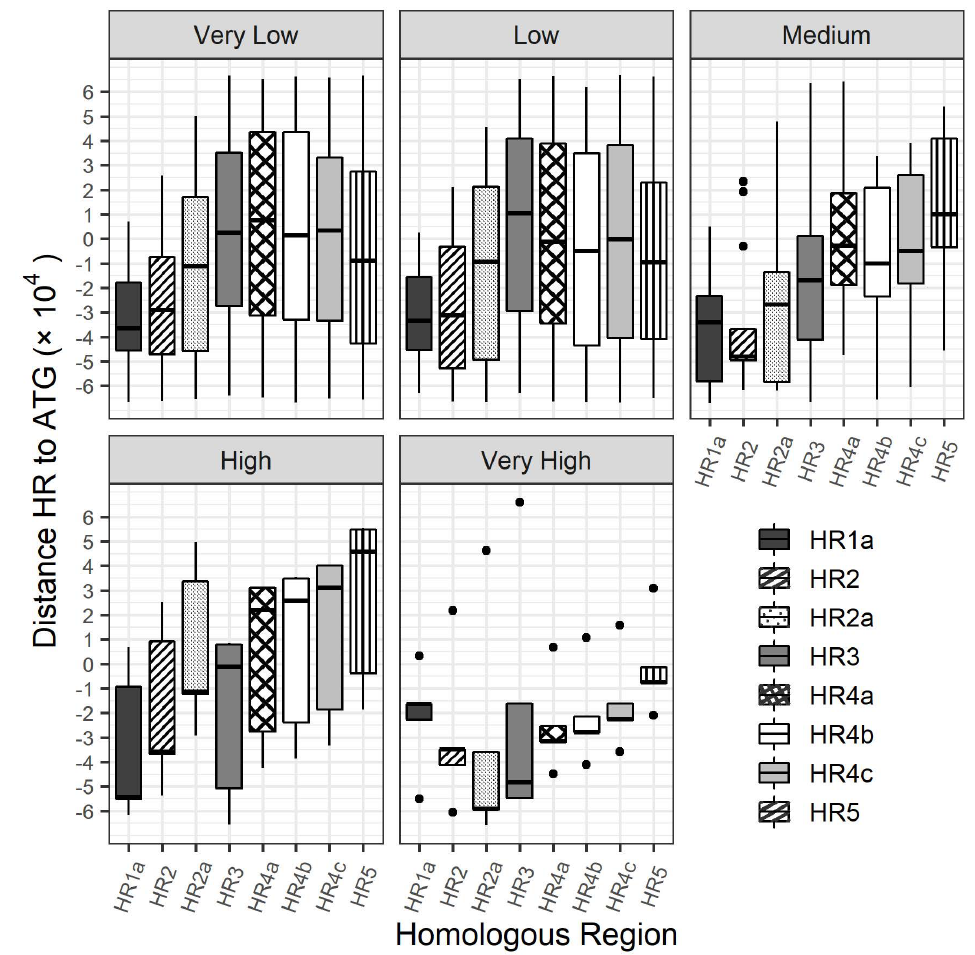
Figure 6. Distance (in nucleotides) between the start codon and 5 (cid:48) end of each homologous region for every Ac MNPV ORF categorized according to transcript abundance. The distance was calculated by subtracting the genomic location of the 5 (cid:48) end of each Ac MNPV ORF from the genomic location of the 5 (cid:48) end of each hr . Positive values represent ORFs located behind (clockwise) to the hr and negative values represent distances between ORFs that are located in front of (counterclockwise) the hr